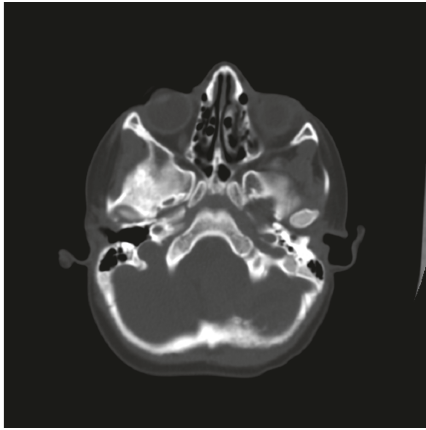
Figure 2: Axial CT scan bone window shows loss of the inner skull table and cortical outline with permeative bone reaction indicating bone